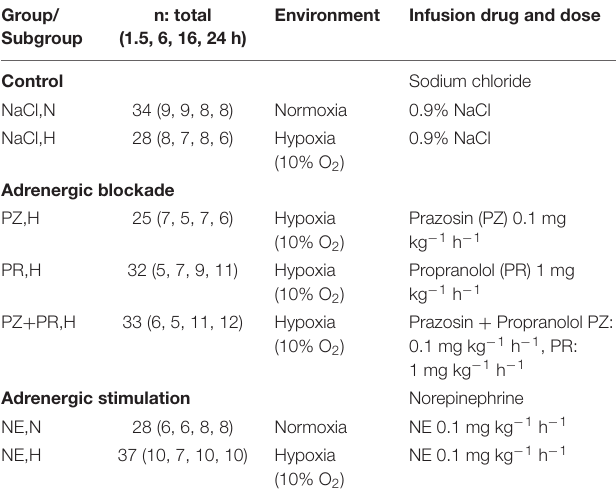
TABLE 1 | List of